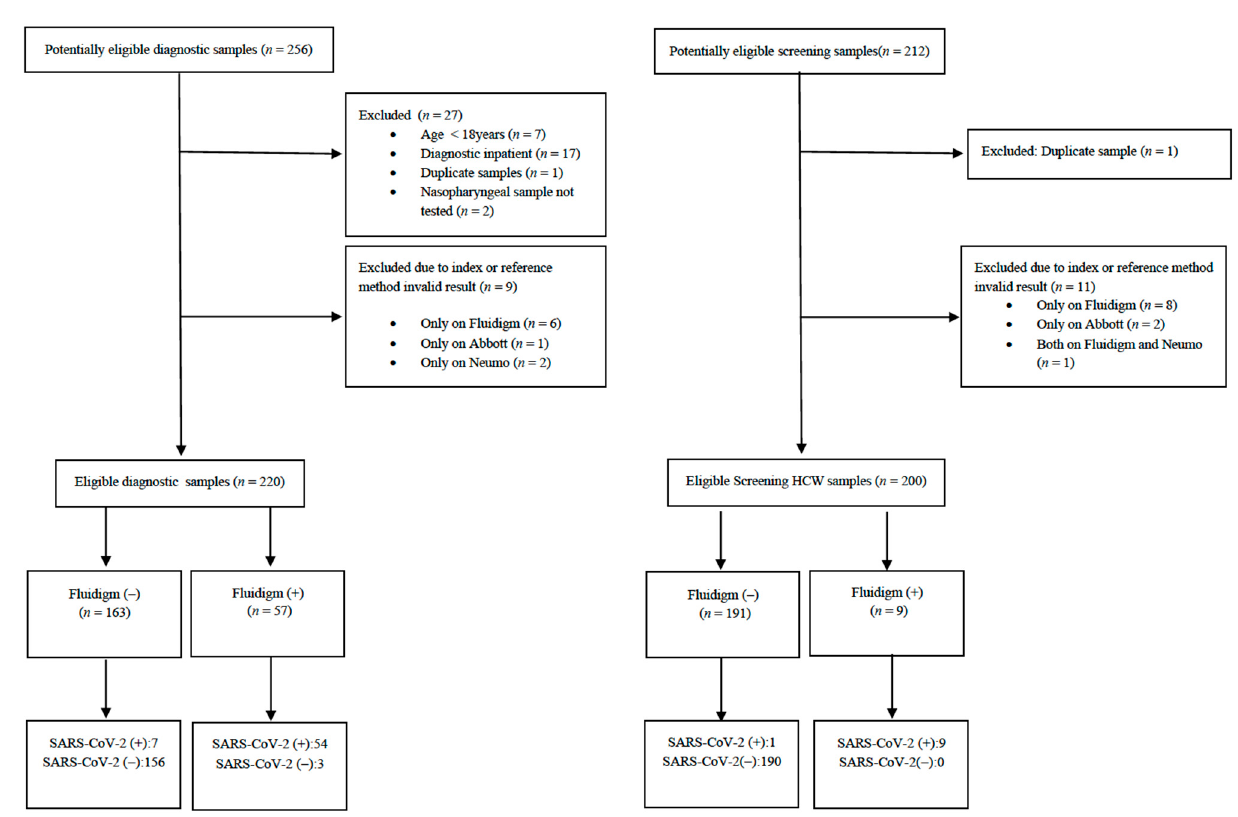
Figure 1. Diagnostic accuracy of Advanta™ Dx SARS-CoV-2 RT-PCR saliva-based assay versus paired nasopharyngeal specimen samples: study flowchart.